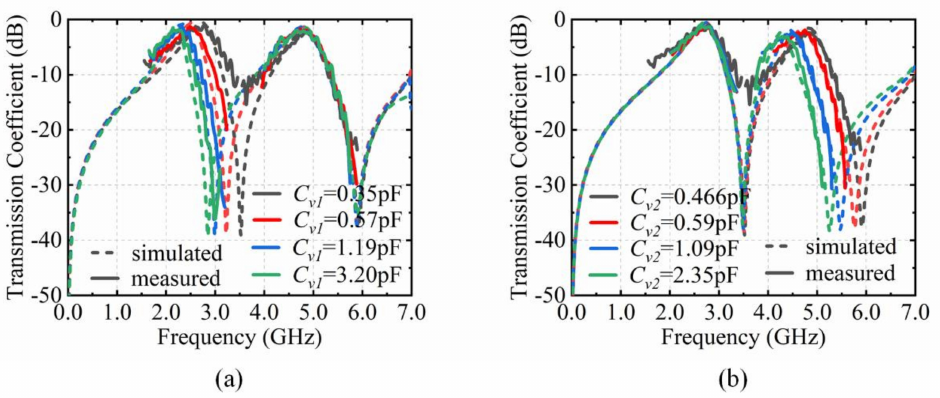
Figure 8. Comparison of measurement results and simulation. ( a ) Transmission coefficient with C v 1 from 0.35 pF to 3.20 pF. ( b ) Transmission coefficient with C v 2 from 0.466 pF to 2.35 pF.